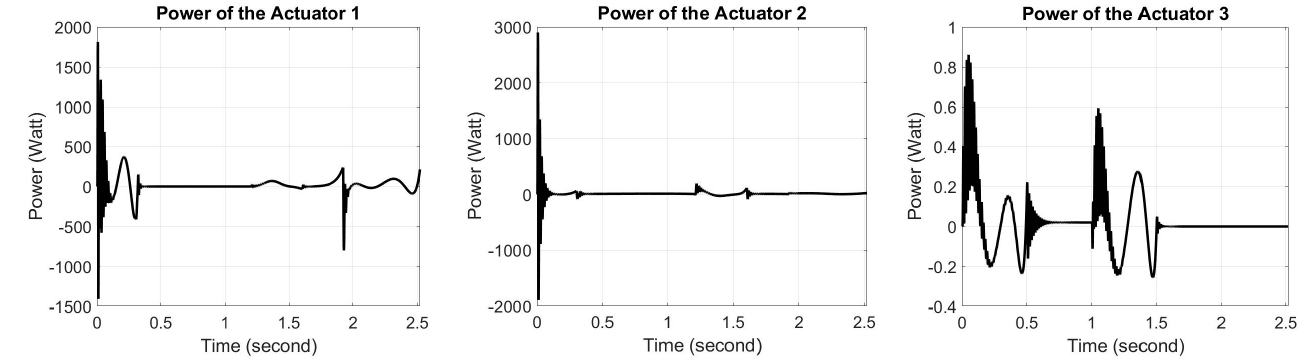
Figure 11. Power consumptions of the actuators for a gait cycle.